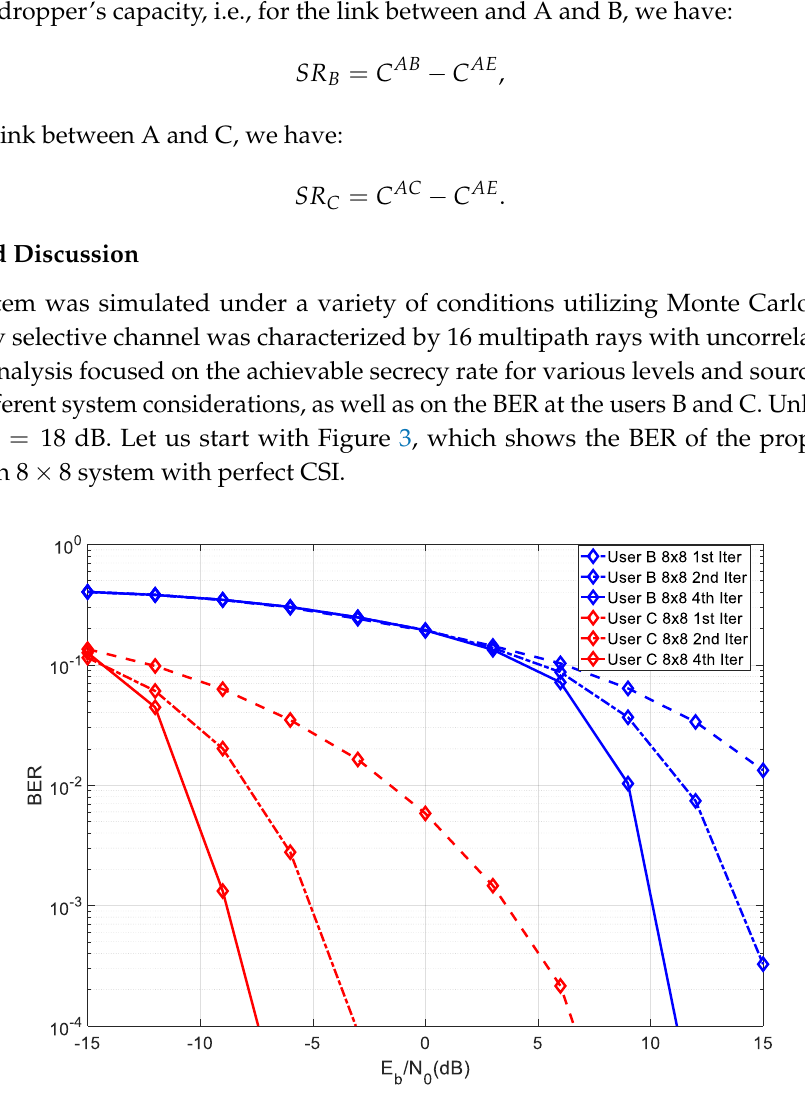
Figure 3. BER of both legitimate users for an 8 × 8